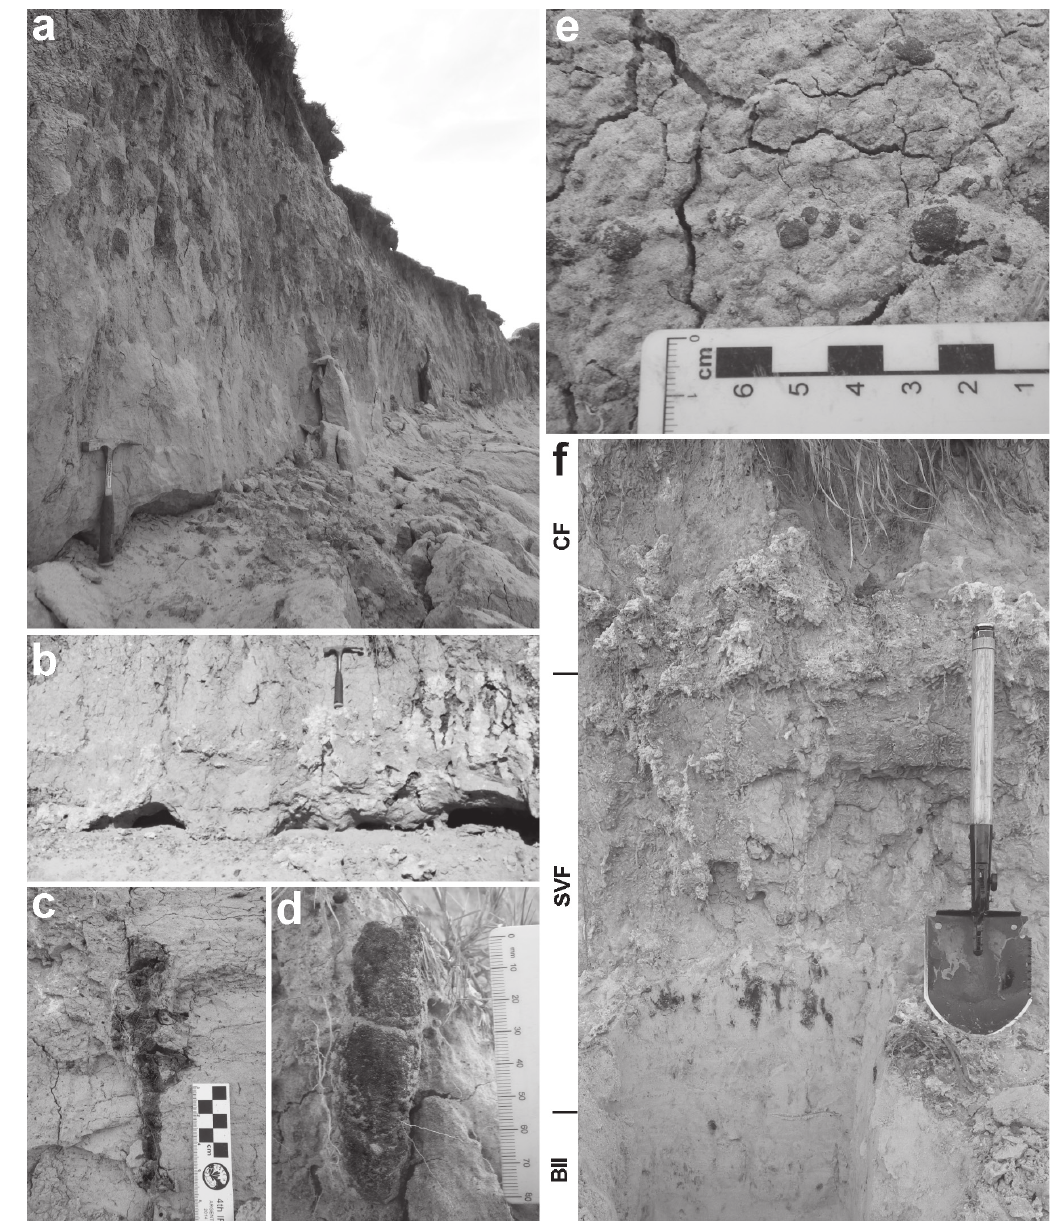
Figure 5 - a: vertical walls formed by loess on the right bank of Chuy Creek. b: cavities at the base of the loess, caused by erosion of the less cohesive underlying muddy sand. c: plant root remains. d: iron-manganese crust formed around a plant root. e: concentration of iron-manganese nodules. f: caliche nodules at the base of the Cordão Formation (CF) and rhizocretions below, in the Santa Vitória Formation (SVF). (BII = Barrier